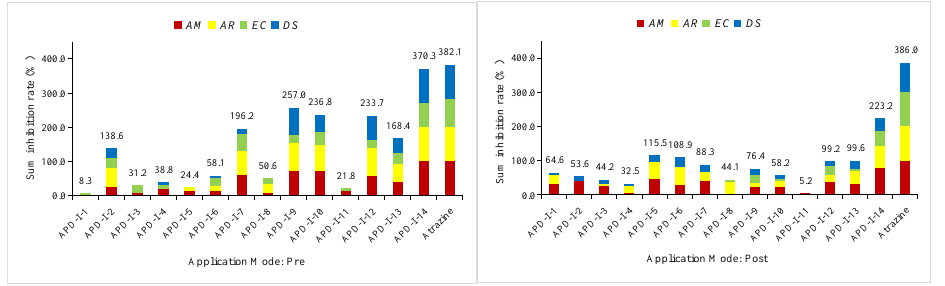
Figure 3. Effects (% inhibition) of target compounds APD-I-1 – APD-I-14 on loss of plant weight at a